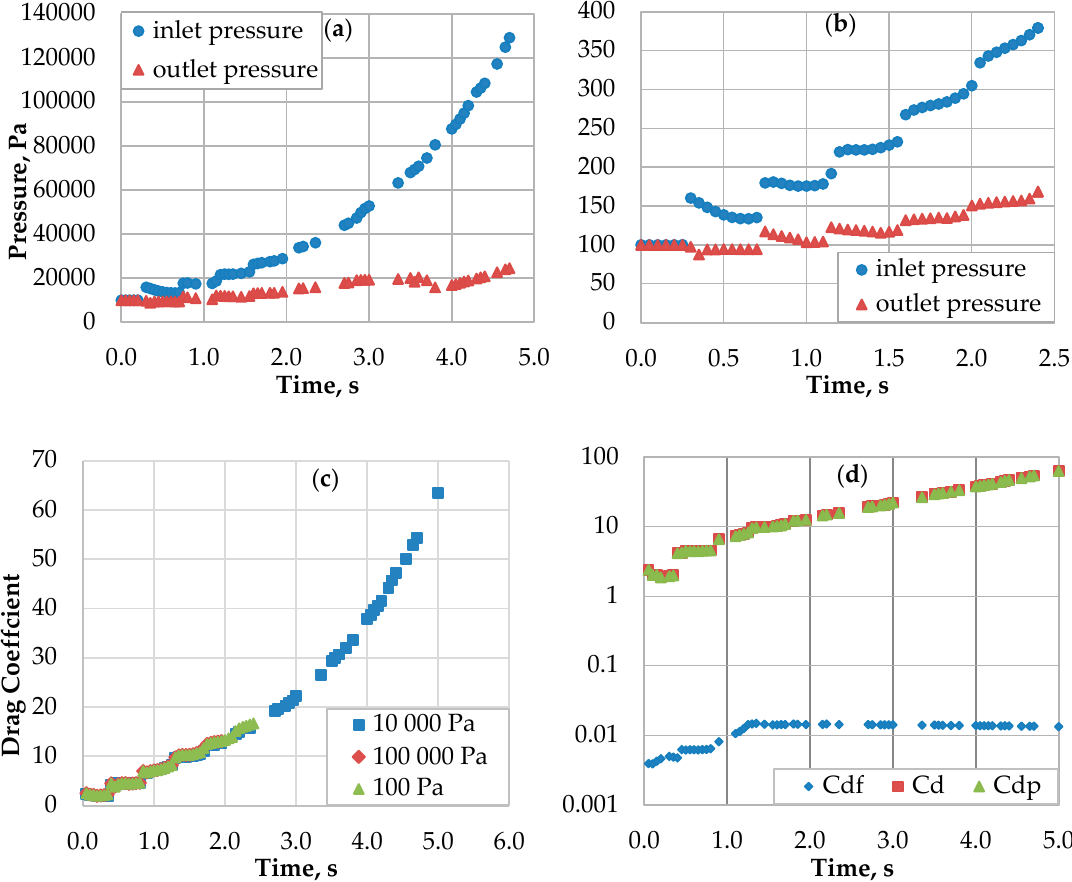
Figure 5. ( a ) The average pressure at the inlet and outlet from the tunnel for 10 kPa; ( b ) for 100 Pa. Results for 166m/s freestream air velocity. The effect of the increasing pressure due to the collection of air in front of the vehicle is visible. ( c ) Drag coefficient for vehicle velocity 166 m/s and various initial tunnel pressure. ( d ) Total drag coefficient and their components, the impact of the skin-friction drag is negligibly small.